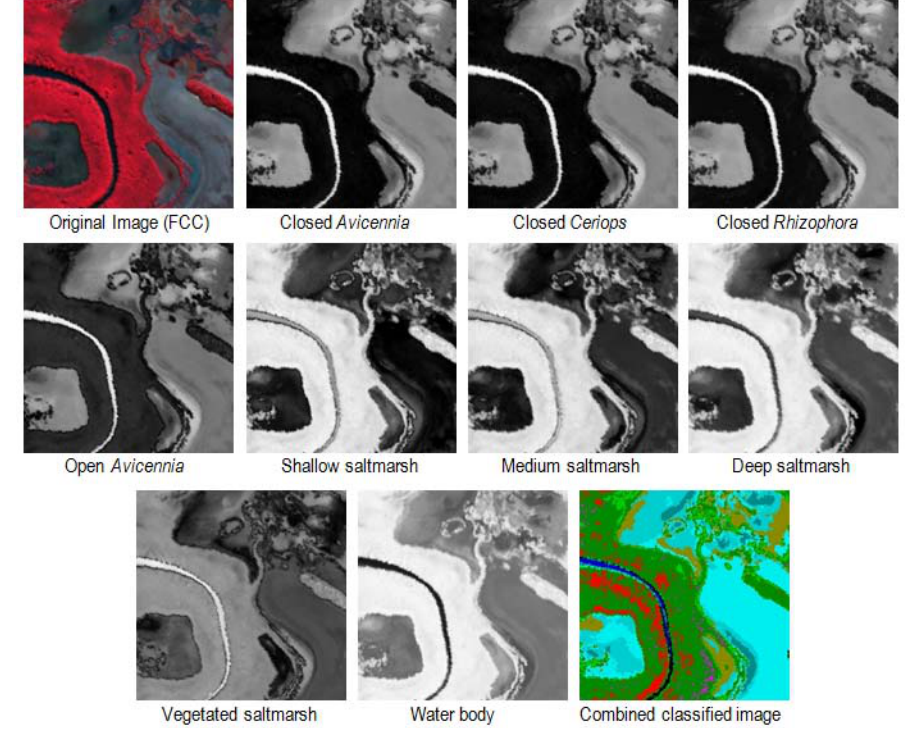
Figure 8. Rule images of each class and combined classes of spectral angle mapper (SAM) (see yellow box in Figure 7 for location subset). The greyscale images show the SAM angle, darker objects represent smaller angle, or high similarity to the reference class. The final image resulted from a combination of rule images based on the smallest angle in each reference